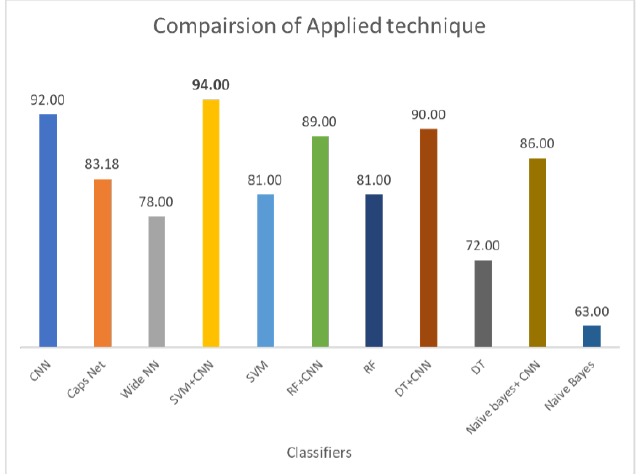
Figure 10. Comparison of all applied techniques on LUNA16